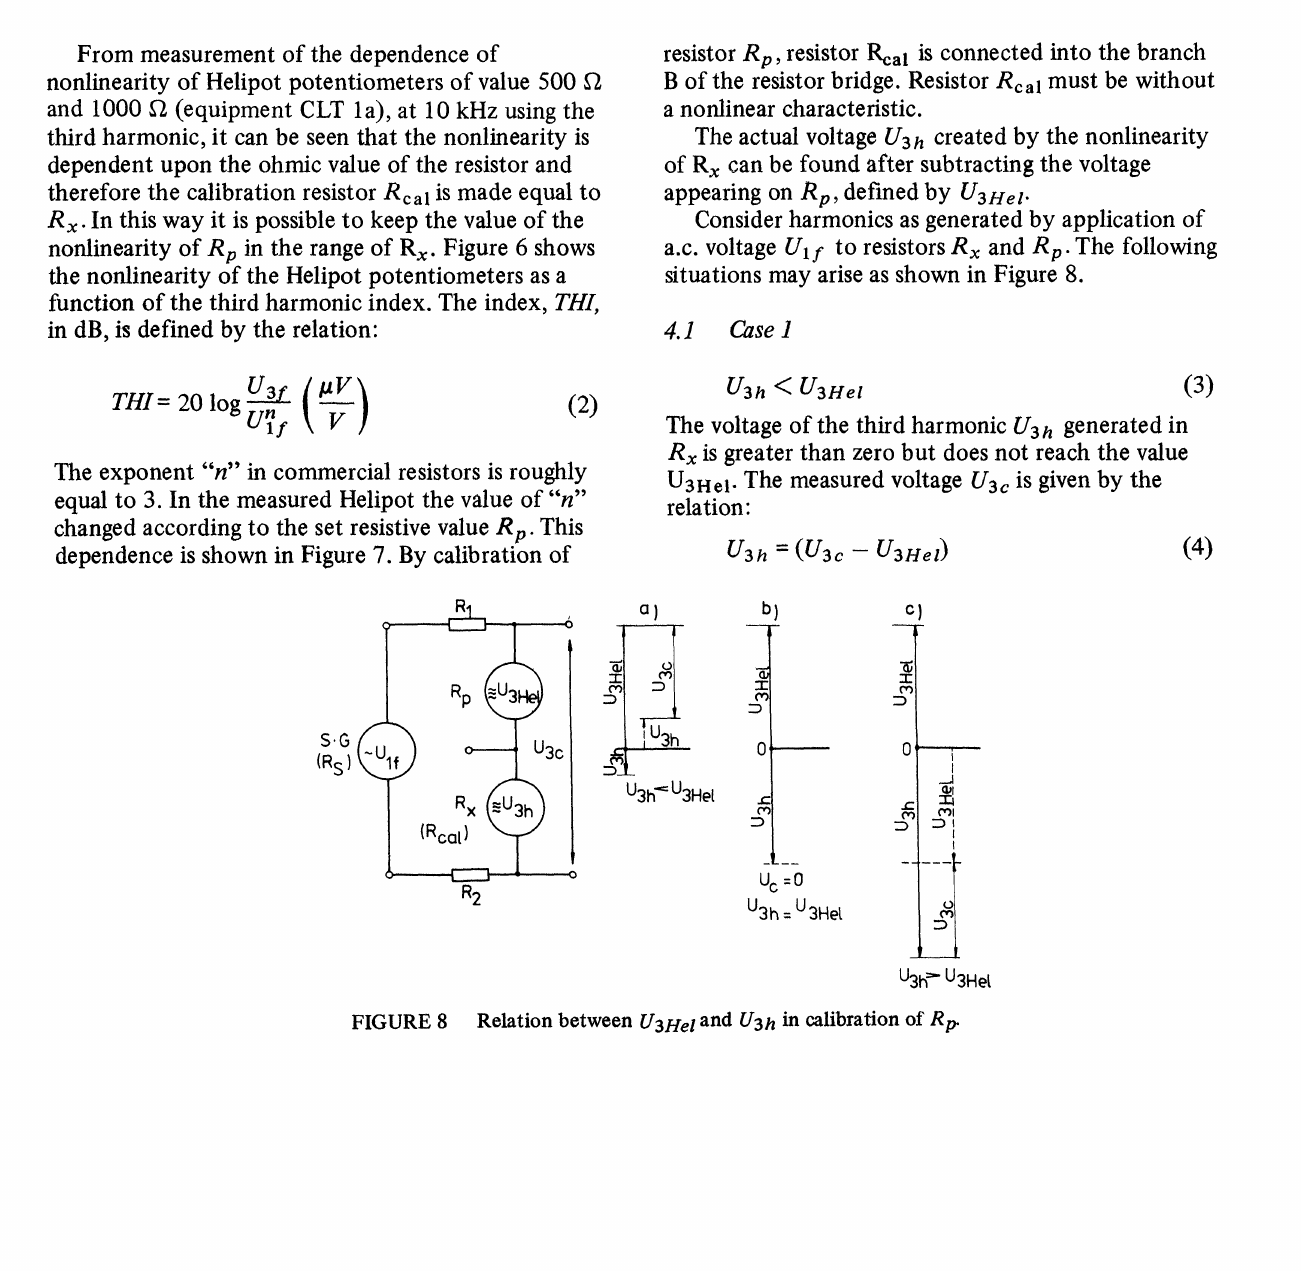
FIGURE 8 Relation between U3Hel and Uah in calibration of